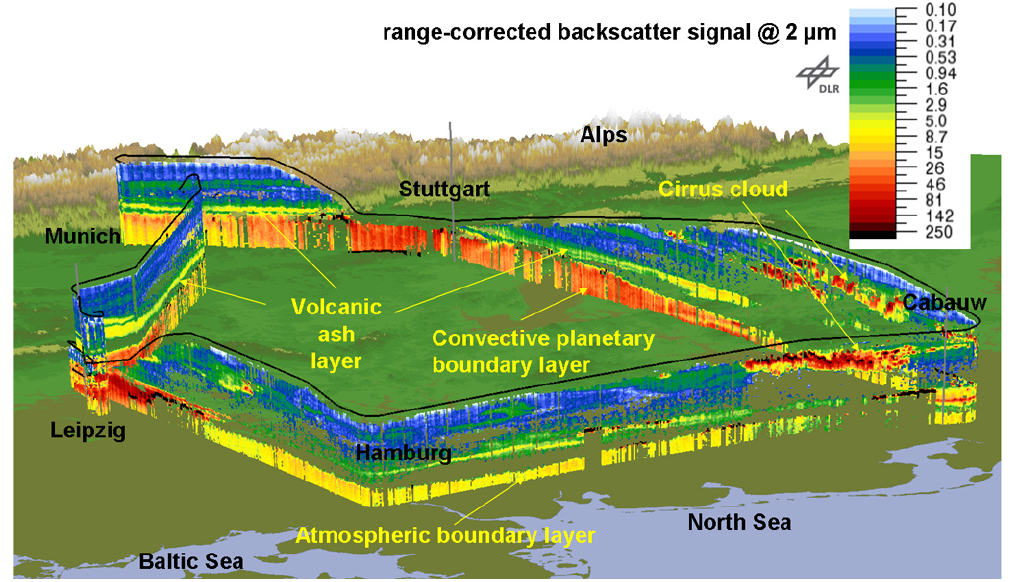
Fig. 9. Lidar cross-section (range corrected backscatter) along flight path over Germany and the Netherlands, with various aerosol layers and cities identified, 19 April 2010. Viewing direction from North to South. The flight altitude above Hamburg was 8.2km.